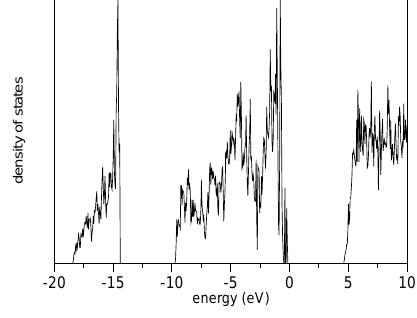
Fig. 3. Calculated DOS for crystalline α phase Si 3 N 4